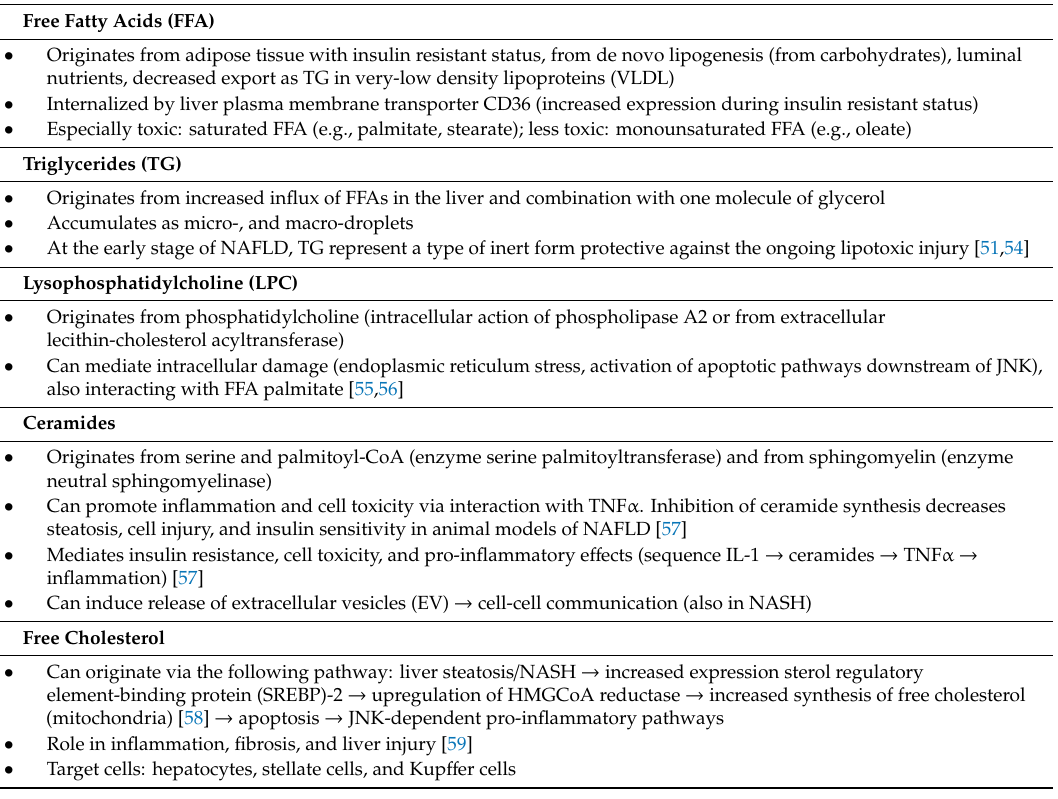
Table 2. Lipid species accumulating in